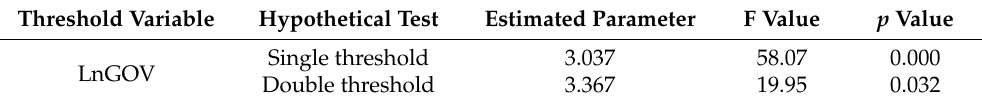
Table 4. Results of threshold conditions test and double threshold estimated